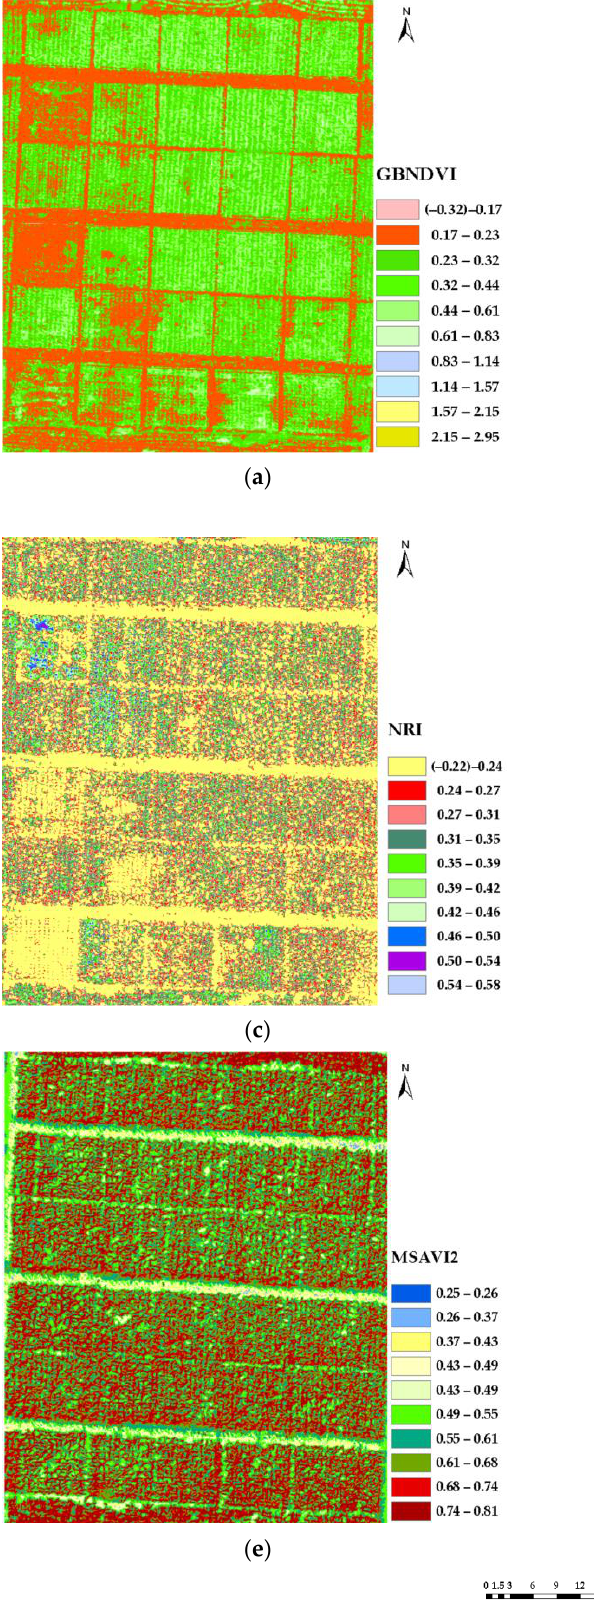
Figure 5. Spatial distribution of nitrogen diagnosis of summer maize plants by UAV at the V6 ( a ), V10 ( b ), V12 ( c ), R1 ( d ), R2 ( e ), and R3 ( f ) growth